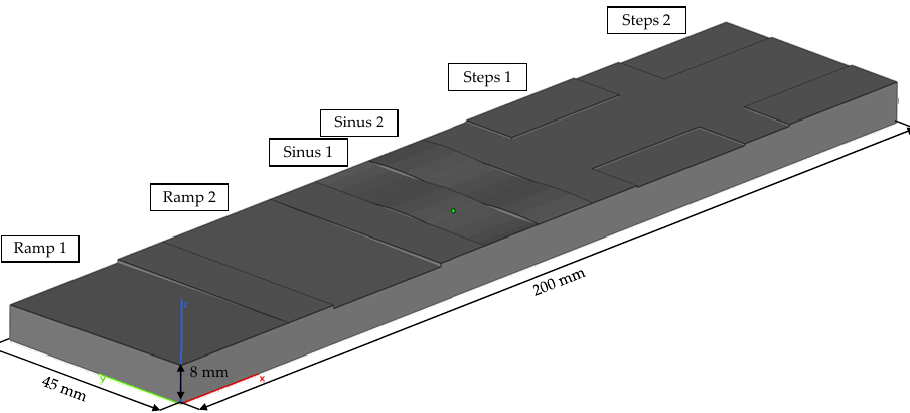
Figure 9. Schematic illustration of the concept casting part, upside view. The upper side of the casting is directly opposite the downskin side of the sand mold, while the lower side faces the upskin side of the sand mold. There are six relevant areas on the downside and the upside of the casting with the aim of having the same geometric features. We used the smoothening parameter set to create two ramps, ramp 1 and ramp 2, which face di ff erent directions. Each ramp surpasses two layers, reaching a total 0 .7 mm nominal height di ff erence between the three layers. Therefore, they represent the smooth- ened equivalent of steps 1 and steps 2, in which we used conventional printing techniques to bridge the height di ff erence. In the middle of the part, there are two sinusoidal surface waves. The waves are phase-shifted and designed to reach a total of 0 . 3 5 mm height dif- ference between minimum and maximum. As described above, we designed the same fea- tures on the downside of the casting. The gates and the air pipes are placed in between the relevant areas.